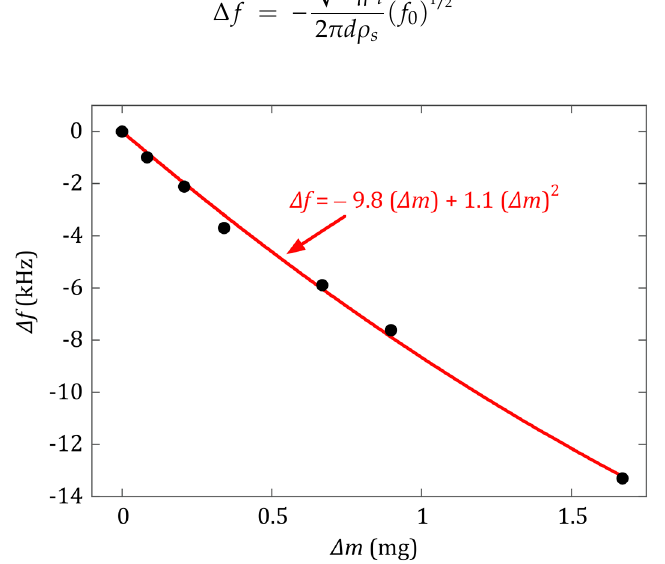
Figure 2. Calibration curve obtained from the changes in the resonance frequency of the Fe 73 Cr 5 Si 10 B 12 resonator (measured in air), caused by di ff erent calcium oxalate mass depositions on its surface. Black dots represent the measured calibration points. The solid red line represents a fit to the second order expression of Equation (3), with coe ffi cients a 1 = − 9.8 kHz / mg and a 2 = 1.1 kHz / mg 2 . Finally, the theoretical values of the mass calibration constants appearing in Equation (3) can be = −7.6 kHz/mg and 𝑎 (cid:2870) = (cid:2871)(cid:3033) (cid:3116) = 0.8 kHz/mg 2 . It can be observed that the calculated to be 𝑎 (cid:2869) = − (cid:3033) (cid:3116) (cid:2870)(cid:3040) (cid:3116) (cid:2876)(cid:3040) (cid:3116)(cid:3118) experimental calibration constants are both 22%–27% higher than these expected values. This kind of discrepancy is observed in other works [24,25]. The origin of the deviation is not clear, but can be related to two aspects: first, an original oversimplification in the derivation of Equation (2), that identifies the